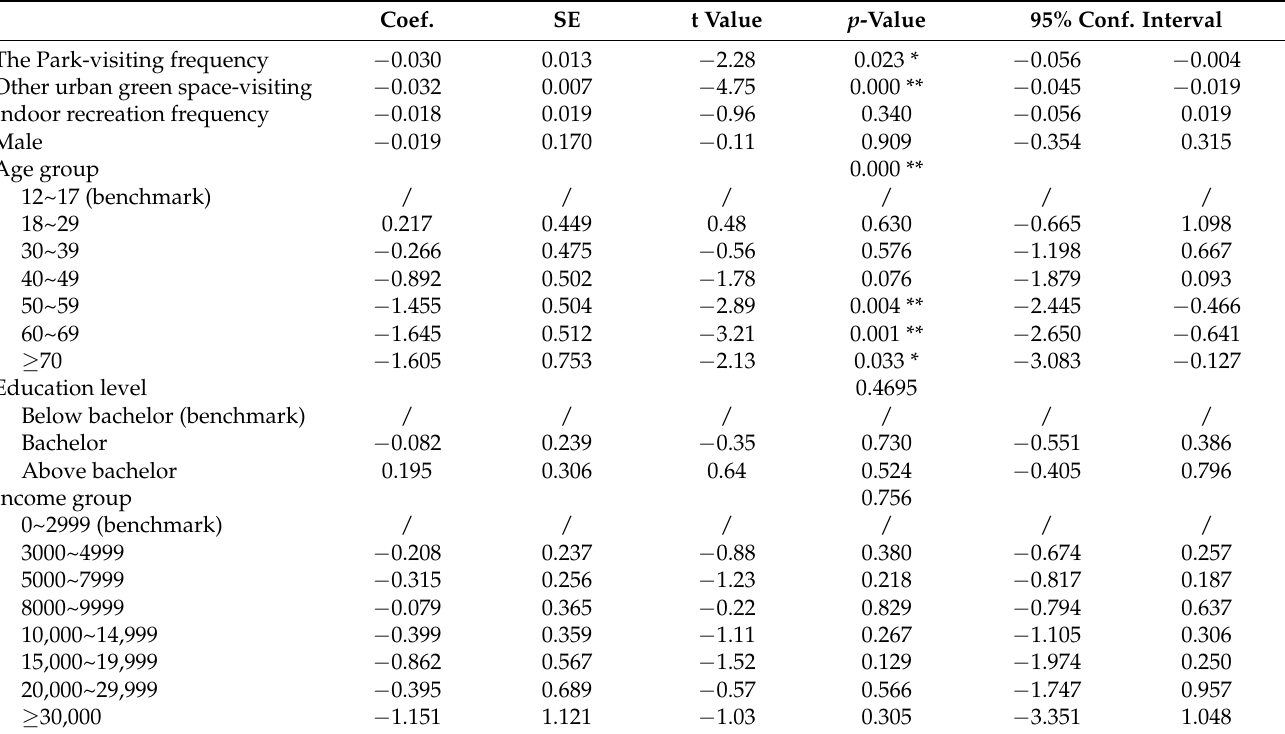
Table 5. Results from general linear regression on perceived stress